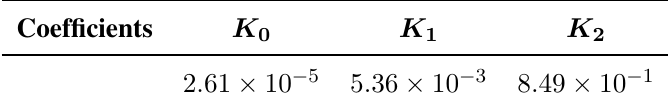
Table 2. Temperature characteristic’s